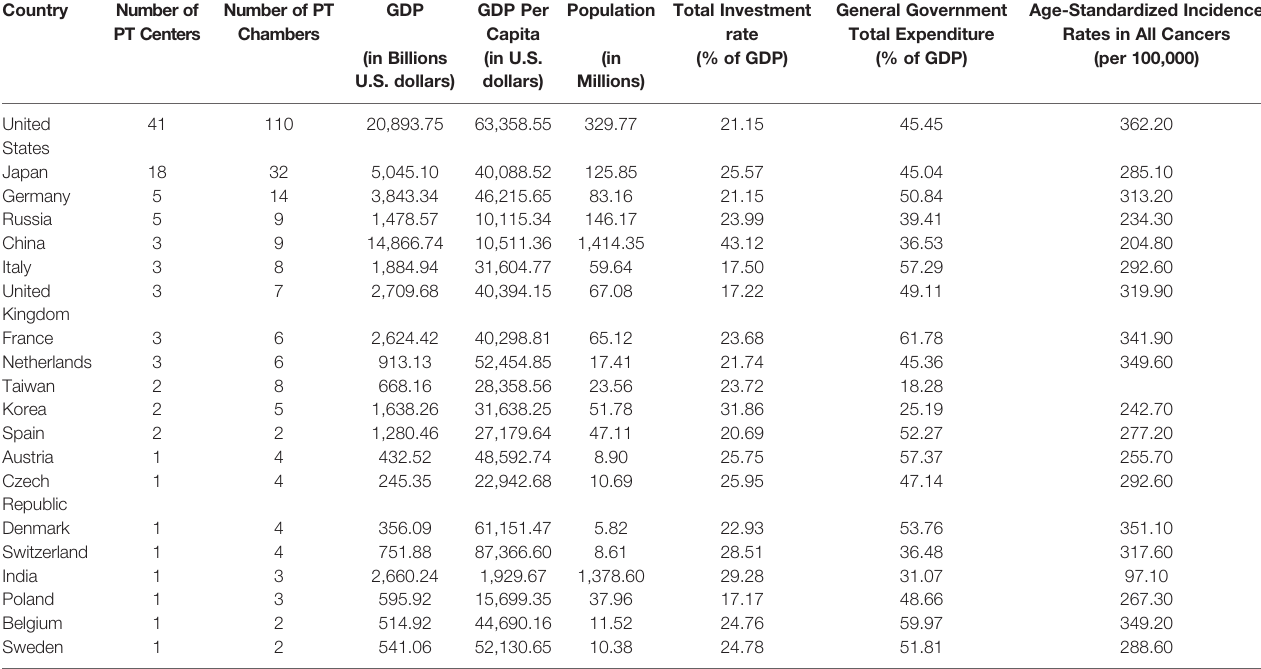
TABLE 1 | Characteristic of countries or regions with PT centers in operation. Country Number of Number of PT GDP GDP Per Population Total Investment General Government PT Centers Chambers Capita rate Total